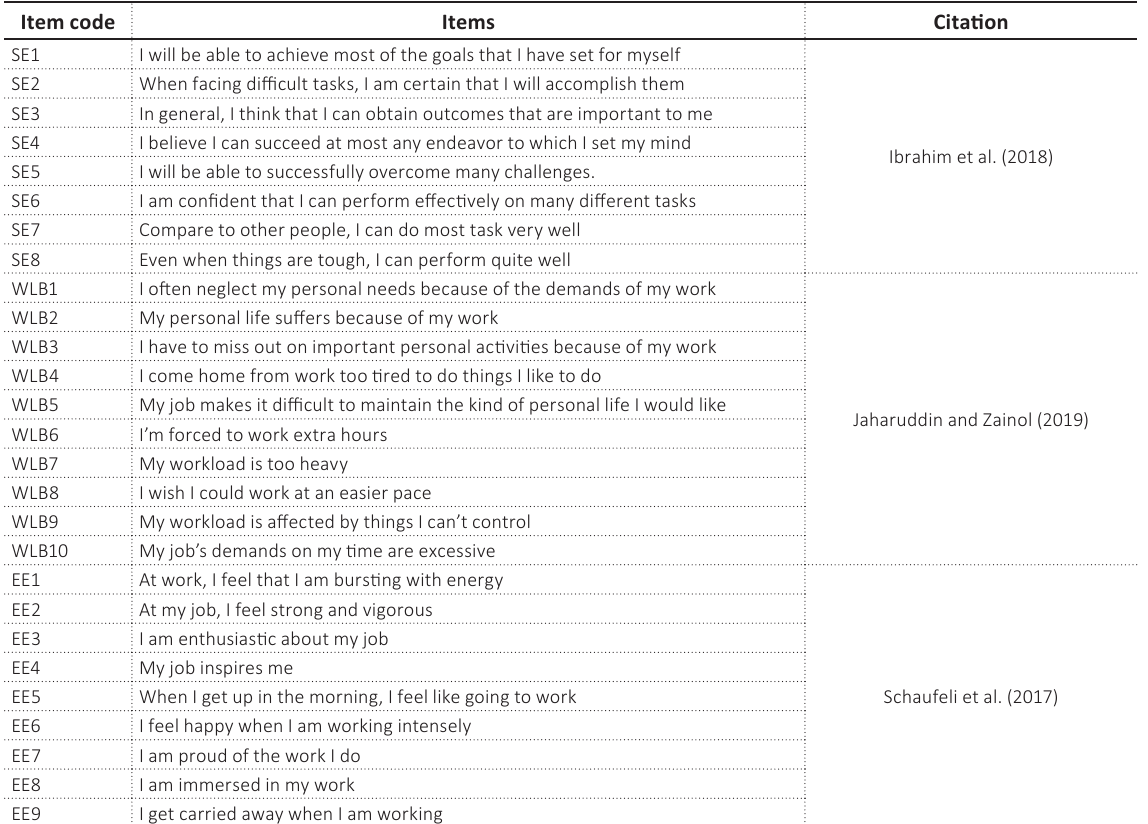
Table 1. Description of the research instrument Item